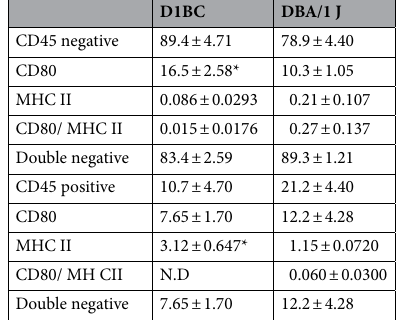
Table 1. Expression of MHCII and CD80 in isolated synovial cells from pannus. Data are presented as mean ± SE of each cell surface marker in isolated synovial cells (four mice). Asterisks show P < 0.05 compared with DBA/1 J mice. N.D. indicates not detected.